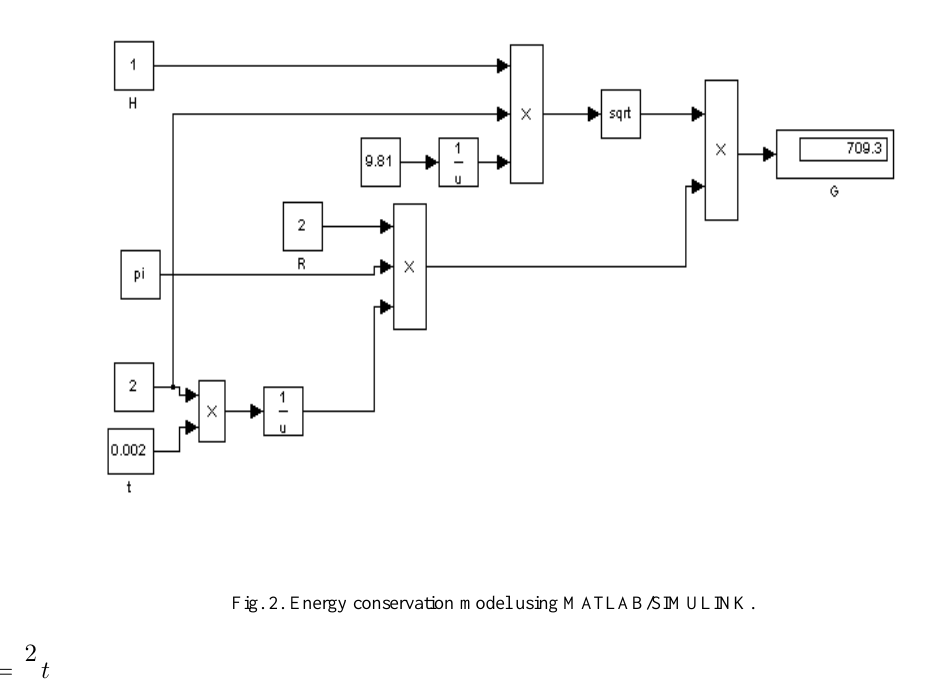
Fig. 2. Energy conservation model using